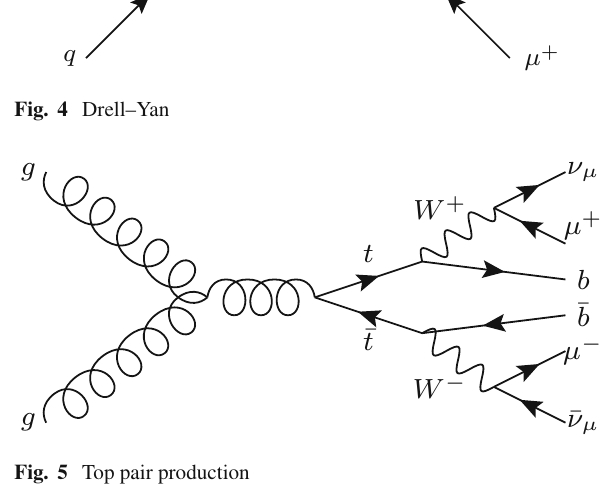
Fig. 5 Top pair production